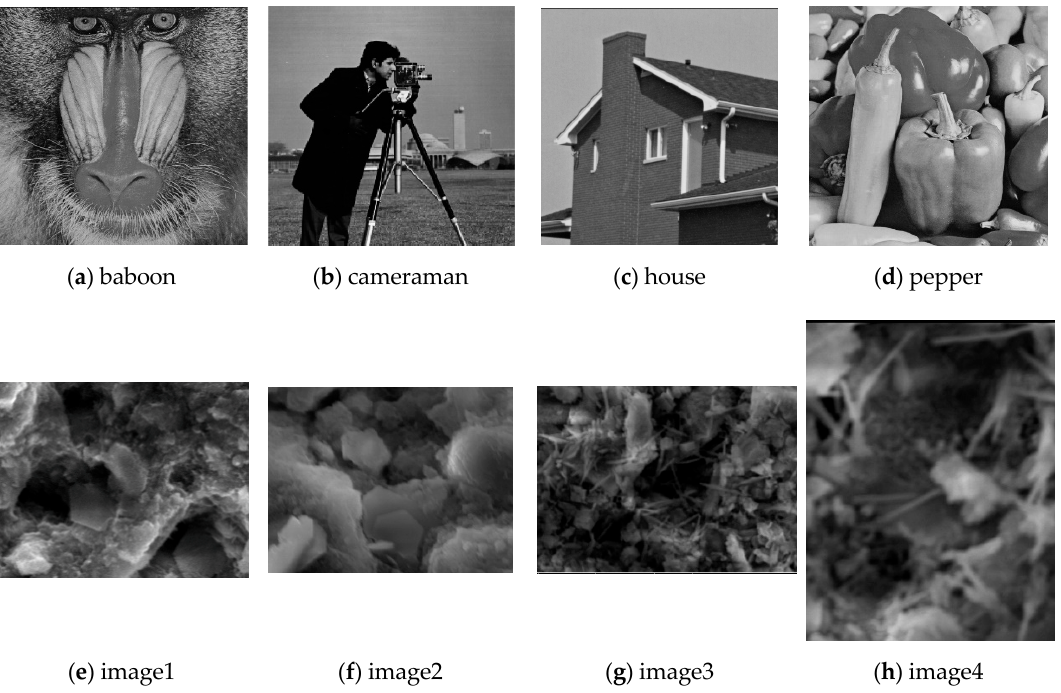
Figure 3. The eight images used in the experiment.